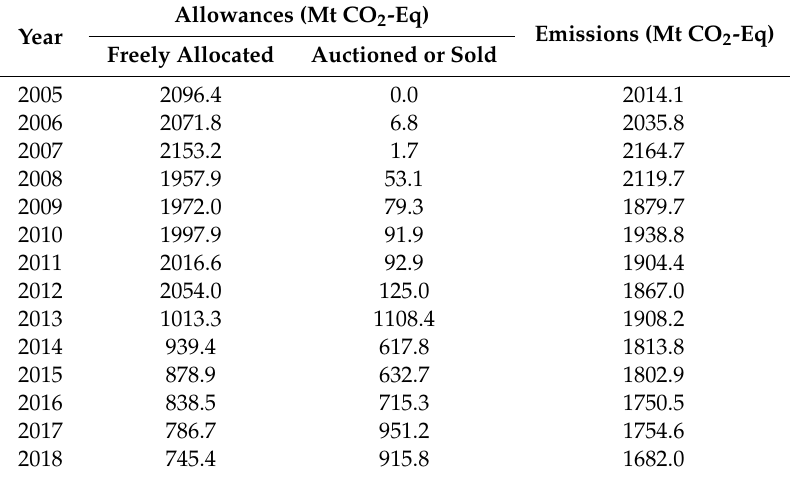
Table 2. EU ETS allowances and